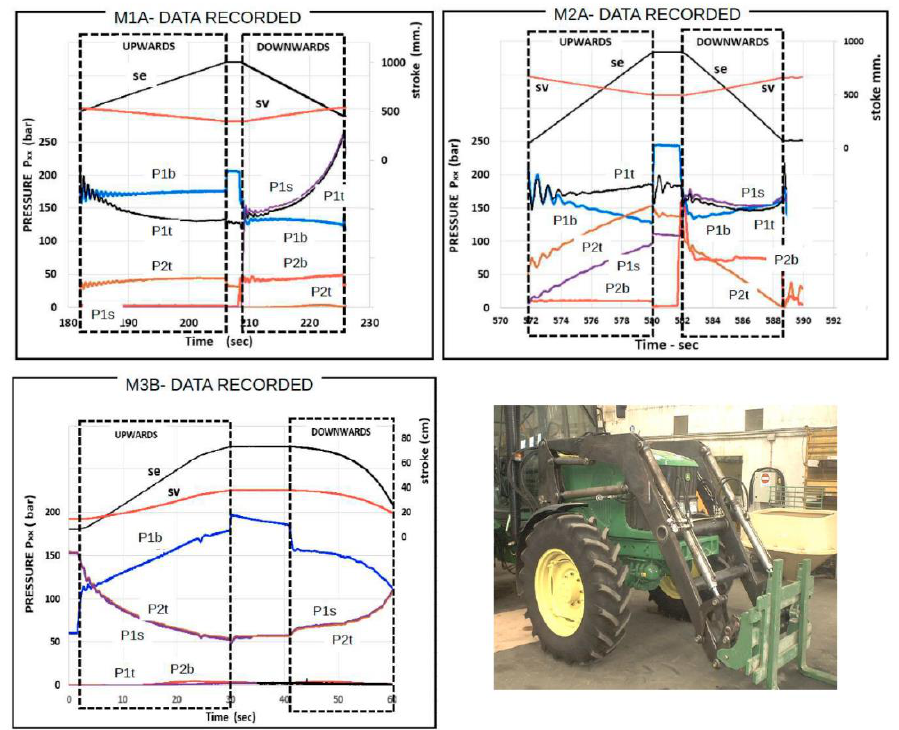
Figure 3. Typical graphs of the variables that were recorded as a function of time for the three proposed machines.